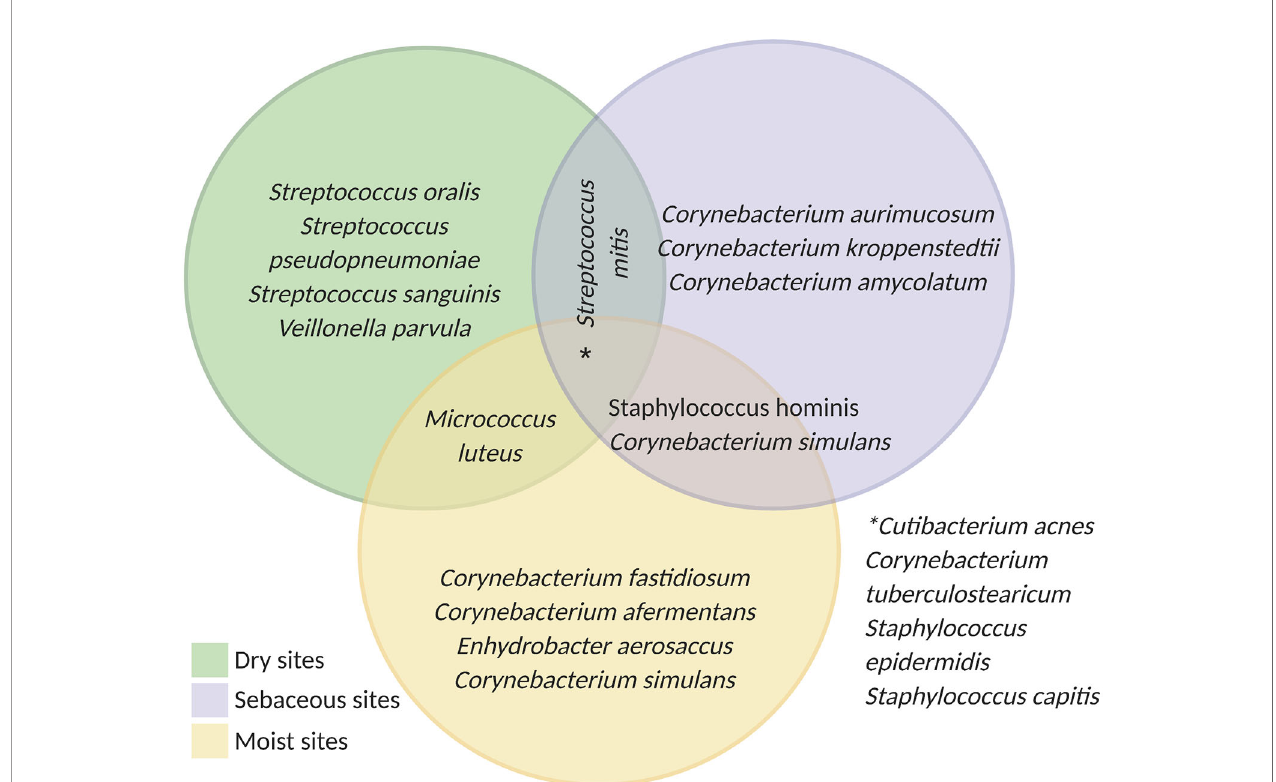
FIGURE 1 | Schematic of skin microbiota according to the physiological sites: dry (green): buttock, volar forearm, hypothenar palm; moist (yellow): plantar heel, popliteal fossa, toe web space, axillary vault, and nare; sebaceous (purple): back, occiput, retroauricular crease, and glabella. Developed using data from